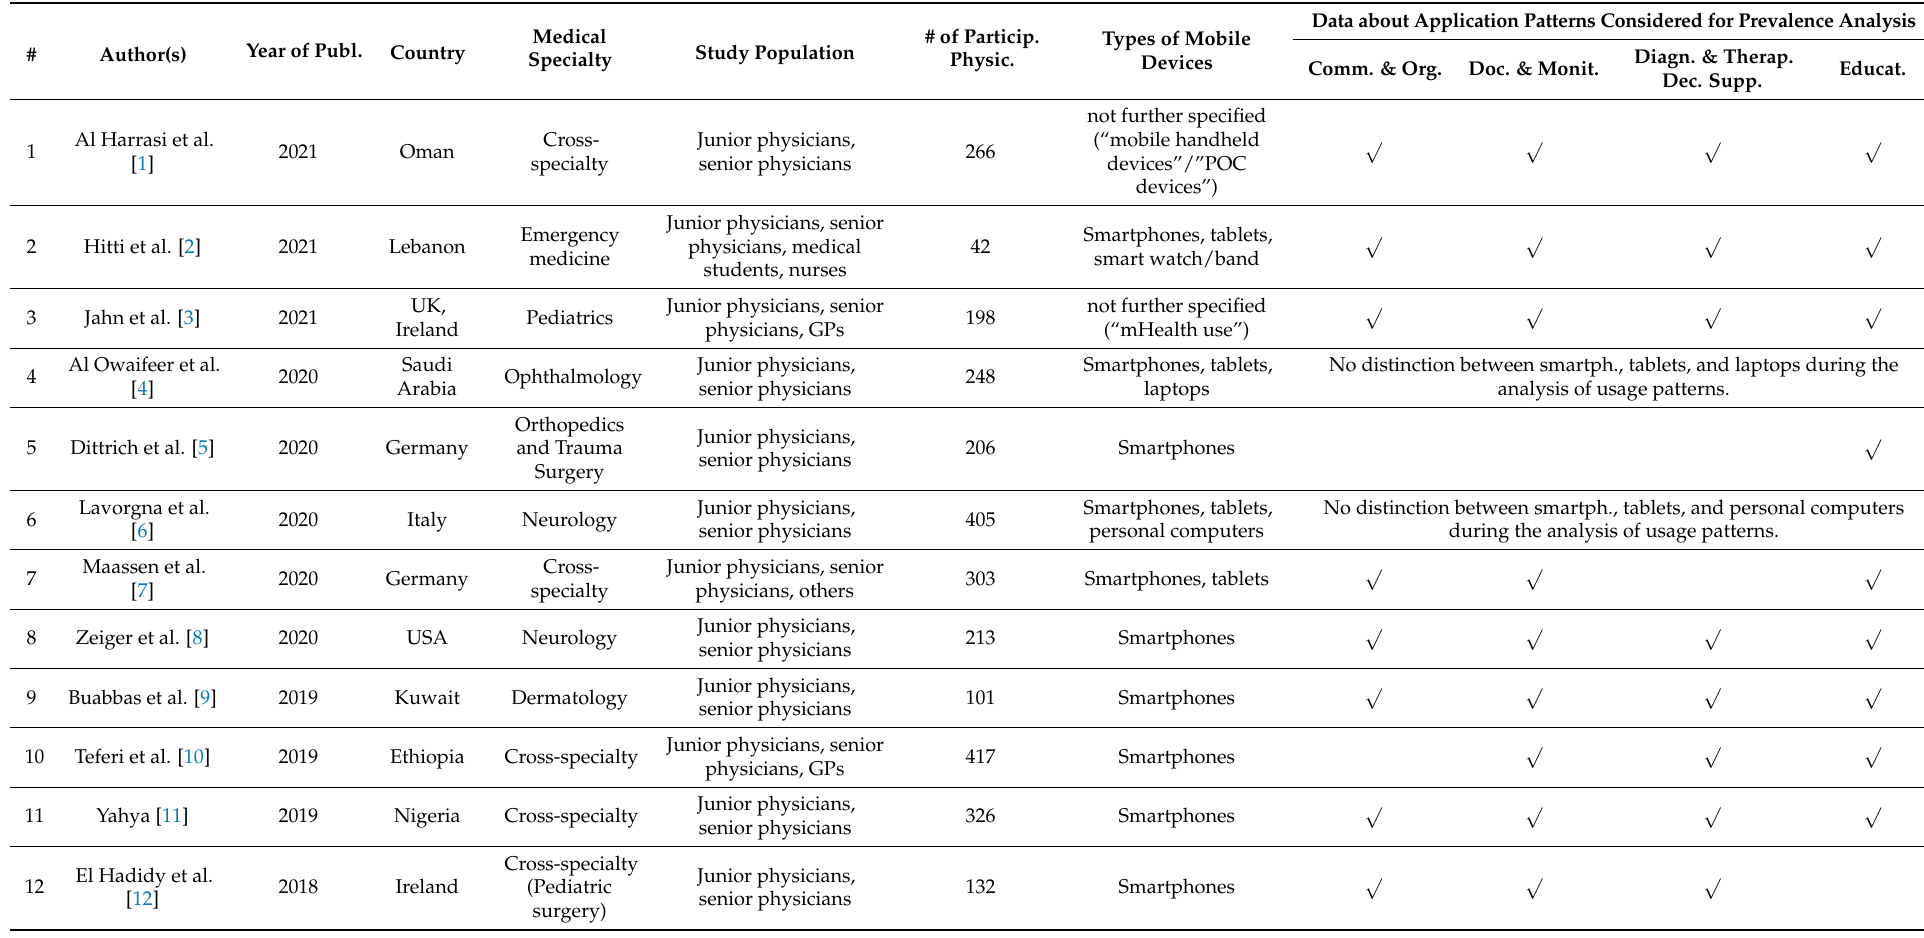
Table A1. Current Mobile Health